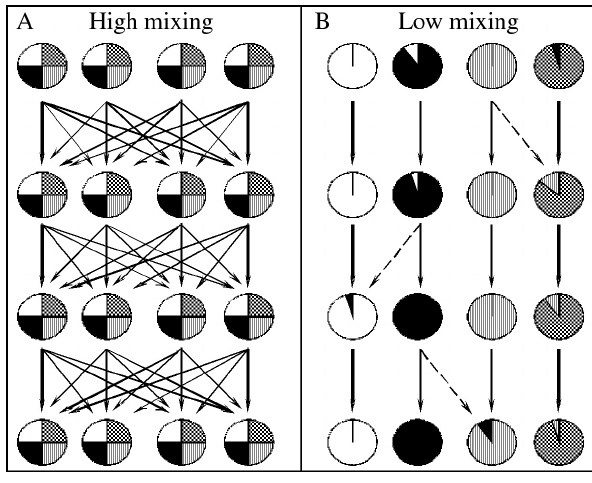
Fig. 1. – Schematic showing how patterns of parasite genetic varia- tion among hosts can be used to infer the transmission process. Circles represent individual definitive hosts. Patterns within circles are different parasite genetic variants. Four generations (rows from top to bottom) of adult parasites and hosts are illustrated. Dashed and solid arrows indicate limited and major paths of recruitment for parasite offspring into definitive hosts, respectively. Parasite offspring may pass through intermediate hosts before reaching definitive hosts. (A) Parasite genetic variation is randomly distributed among hosts with a high amount of mixing among parasite offspring before recruitment into definitive hosts. This pattern indicates that hosts are randomly sampling from a common parasite gene pool. (B) Low mixing of parasite offspring ( i.e ., clumped transmission) predicts high genetic differentiation among individual hosts. This pattern indicates that hosts are sampling distinct parasite gene pools. These schematics represent the extremes of different transmission processes. In rea- lity, there is likely a continuum among parasite species. Figured was altered from Criscione & Blouin (2006). See also Criscione et al . (2005), Criscione & Blouin (2005) and references therein for a more thorough discussion of parasite transmission inferred from genetic